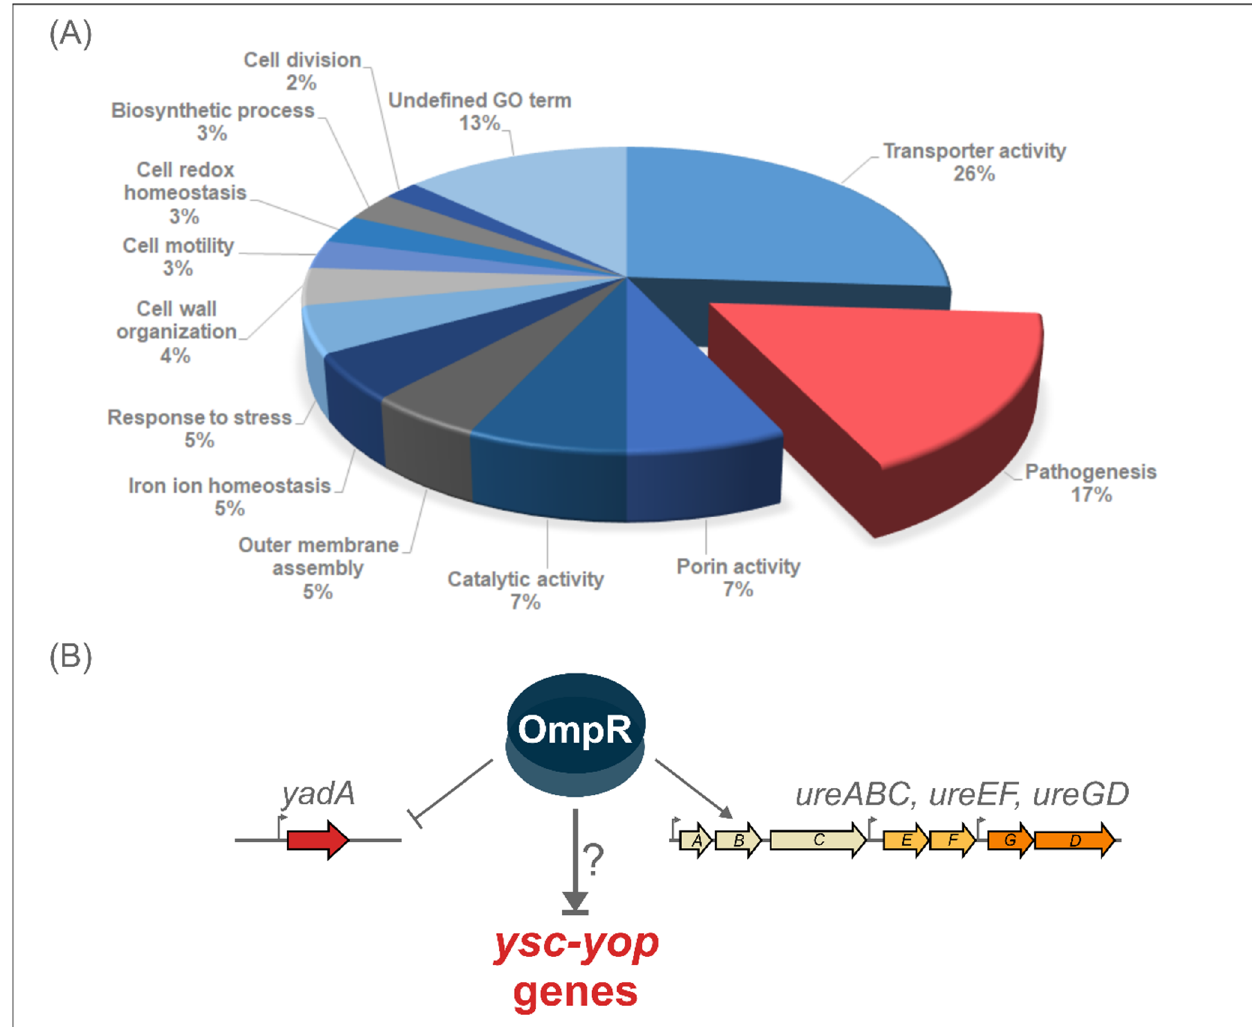
Figure 1. ( A ) Classification of proteins differentially expressed in wild-type Y . enterocolitica strain Ye9 compared with OmpR-deficient mutant AR4 under different growth conditions (temperature, osmolarity and pH) according to Gene Ontology (GO) biological process. The classification of the OmpR-regulated proteins is based on information from the BioCyc database collections, the Uniprot databases and the literature [65]. ( B ) Scheme for OmpR-dependent regulation of pathogenesis genes in Y . enterocolitica 2/O:9 at 37 °C. OmpR downregulates the major adhesin gene yadA [65], but positively affects the expression of ureABC , ureEF and ureGD in Y . enterocolitica strain Ye9 [66]. The influence of OmpR on the Ysc-Yop T3SS genes is investigated in this work.